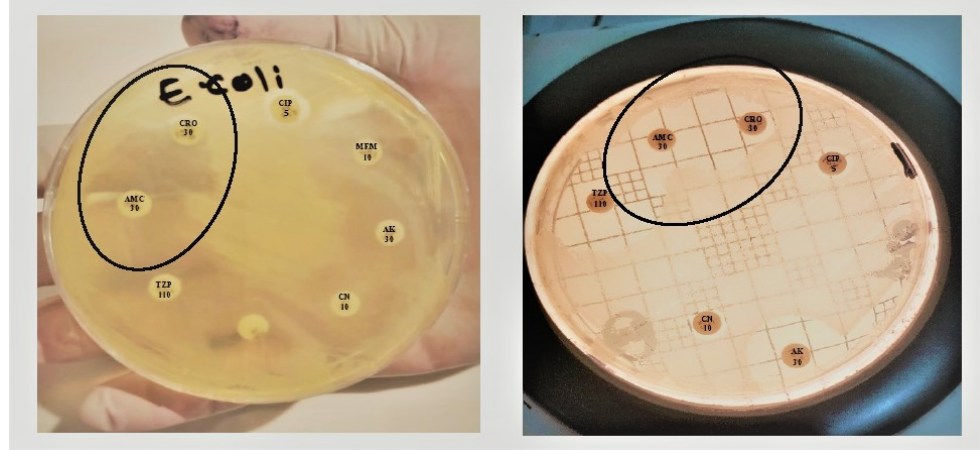
Figure 2. Double disc synergy test (DDST): A decreased susceptibility to ceftriaxone (CRO) is combined with a clear-cut enhancement of the ZOI in front of the Amoxicillin Clavulanate (AMC) containing disk as showed in the circle, often resulting in a characteristic shape-zone referred to as ‘champagne-cork’ or ‘keyhole’.